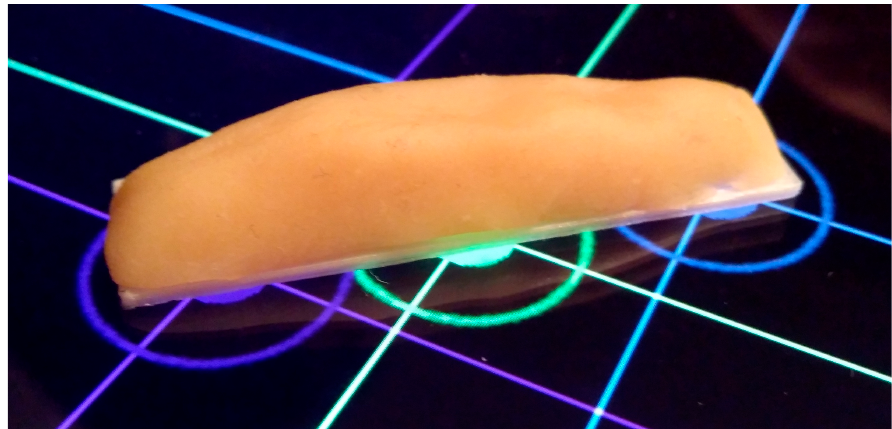
Figure 6. Detection of untouched marker consisting of conductive modeling clay, as insulating part cardboard panel was used. The colored circles and hair crosses indicate, that each pad was recognized by the touch screen.